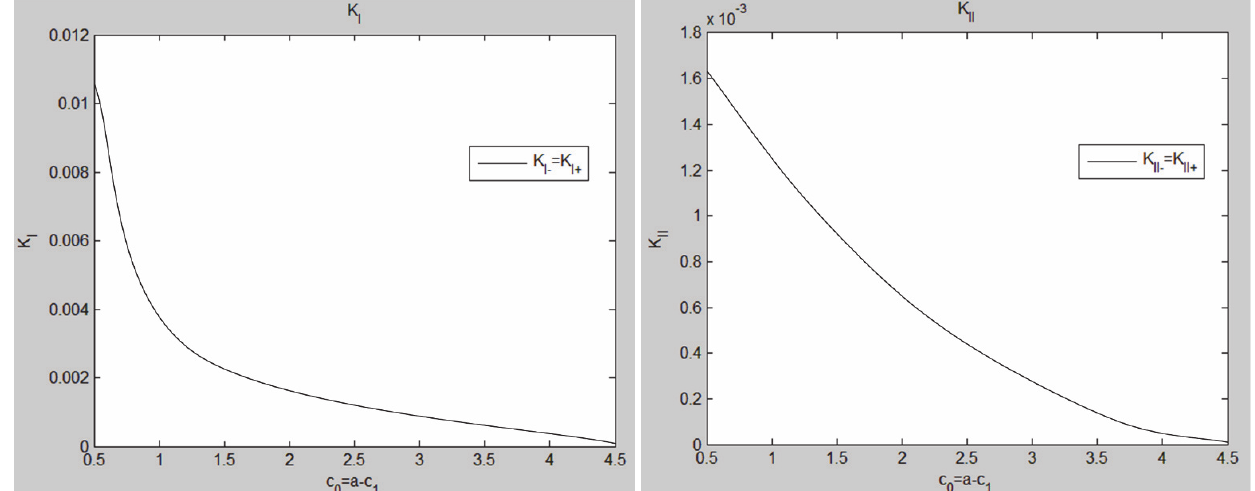
K K when the crack’s size is I II